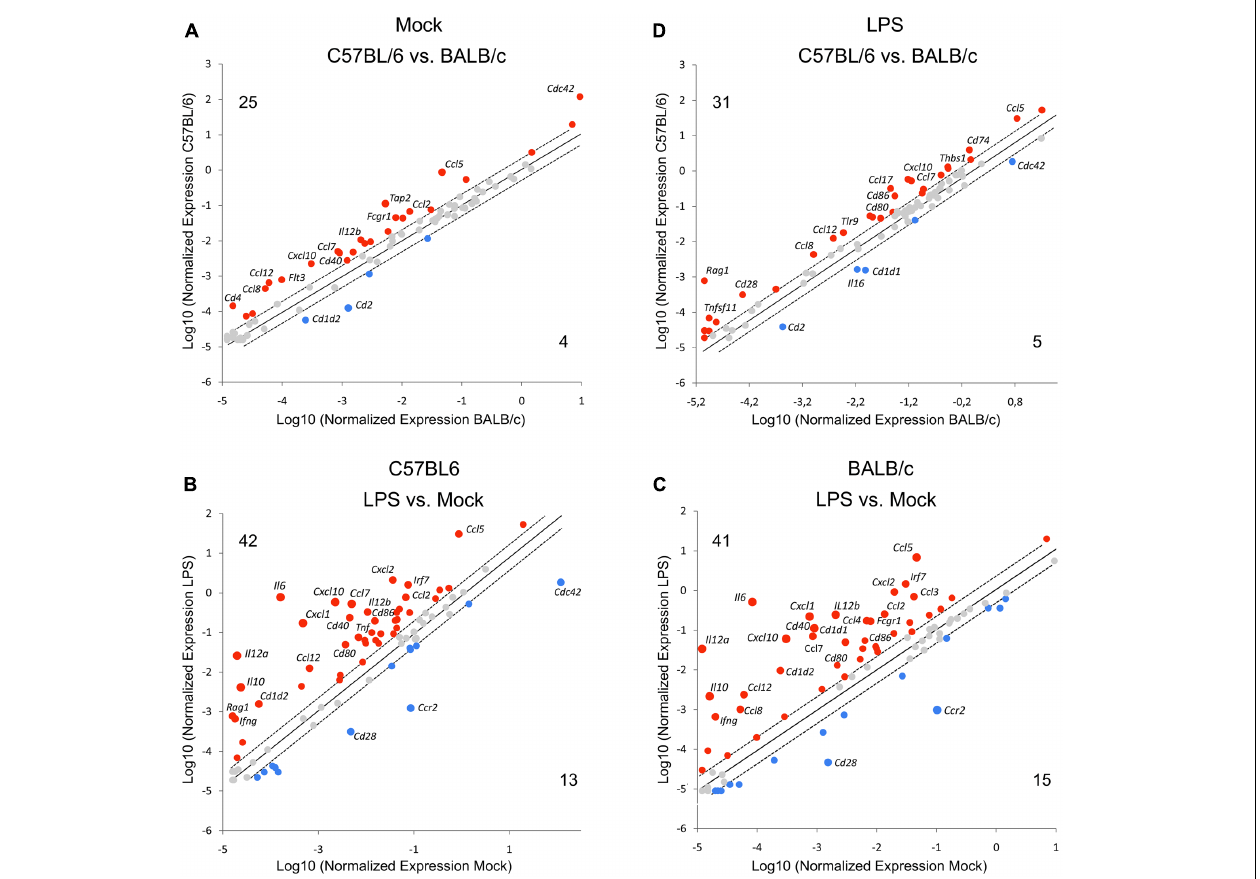
FIGURE 2 | Differential expression of genes involved in innate and adaptive immune functions in GM-BM from C57BL/6 and BALB/c mice. The scatter plots of gene expression profiling in (A) mock-infected GM-BM from C57BL/6 vs. BALB/c mice, (B) LPS-treated vs. untreated mock-infected GM-BM from C57BL/6 mice, (C) LPS-treated vs. untreated mock-infected GM-BM from BALB/c mice, (D) mock-infected LPS-treated (for 24 h) GM-BM from C57BL/6 vs. BALB/c mice. The numbers represent genes that are up-regulated (red) and down-regulated (blue). The cut-offs for twofold induction and repression are indicated by dotted lines (all points having a fold-change less than 2 are shown in